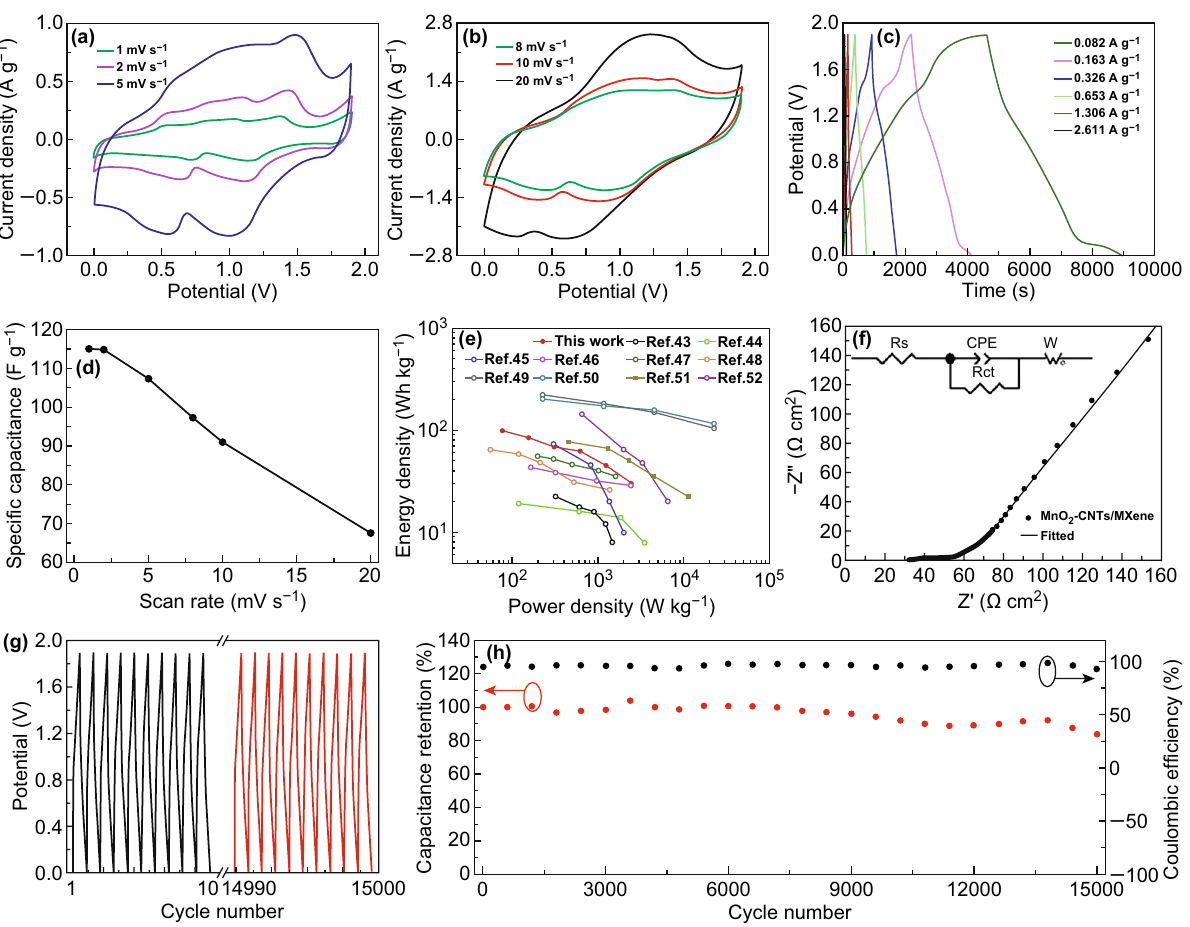
Fig. 4 Electrochemical performance of the ZIC in the aqueous liquid electrolyte. a , b CV curves with various scan rates, c GCD curves with various current densities, d specific capacitance versus scan rate, e energy and power density plot, f Nyquist plot (inset is a fitted circuit dia‑ gram), g GCD curves of the first and last ten cycles, and h cycle life and Coulombic efficiency of the